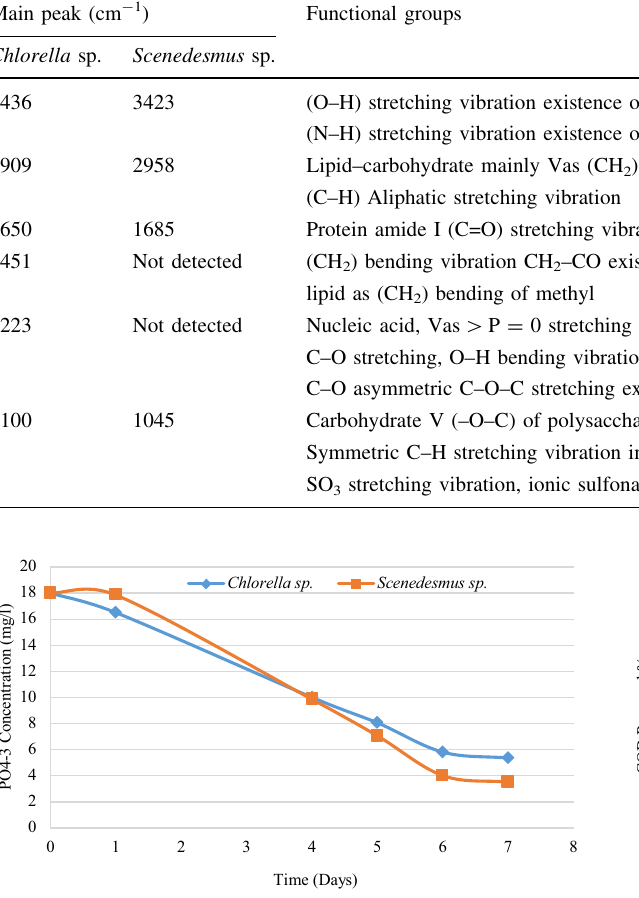
Table 3 Tentative FTIR spectra band analysis of the selected algal strains Main peak (cm - 1 ) Functional groups